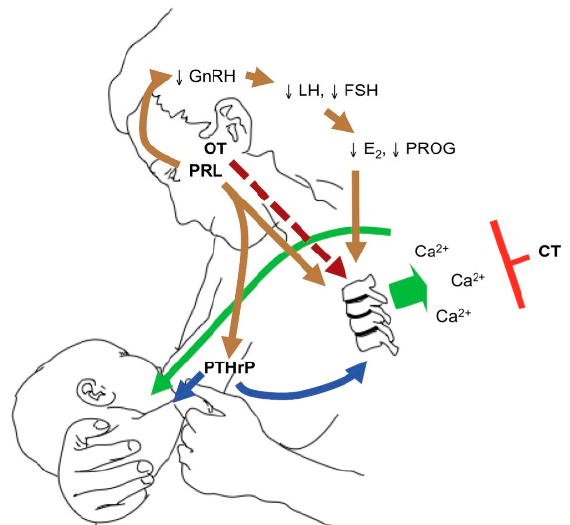
Figure 3. The breast–brain–bone circuit; elevated levels of PTHrP, together with low estradiol, cause bone resorption and the release of calcium and phosphorus in the circulation, which in turn reach the breast ducts and contribute to the formation of breast milk (reproduced with permission from Kovacs, C.S.; Physiology of Calcium, Phosphorus, and Bone Metabolism During Pregnancy, Lactation, and Postweaning; published by Elsevier: Amsterdam, The Netherlands, 2020) [22].